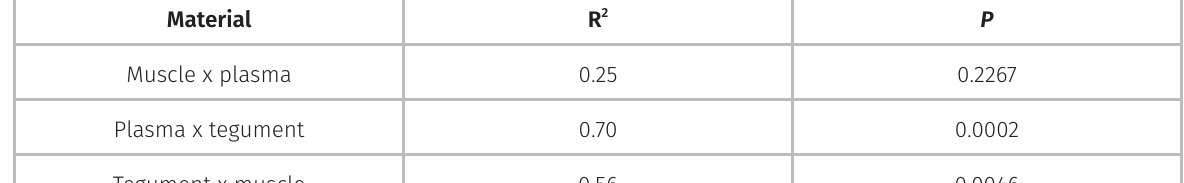
Figure 4. Proportion of total carotenoids of the integument in relation to the muscle (x:y) in L. alexandri fed with ration containing different levels of inclusion of synthetic astaxanthin. Different letters show a significant difference (P<0.05) by the Kruskal- Wallis nonparametric